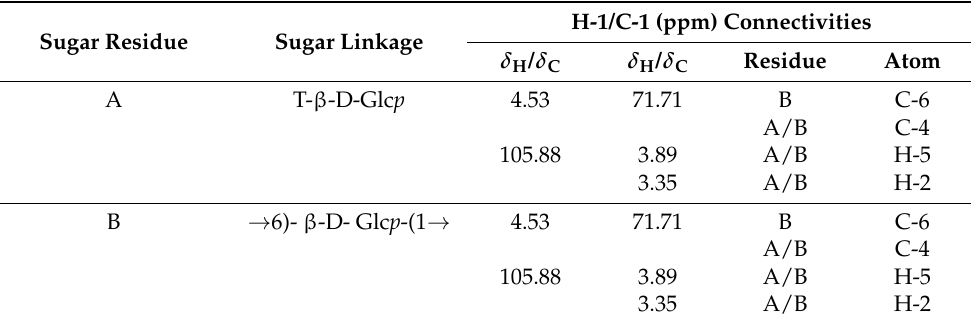
Table 7. Significant connectivity observed in HMBC spectrum for the terminal 1 H and 13 C of the residue fractions of